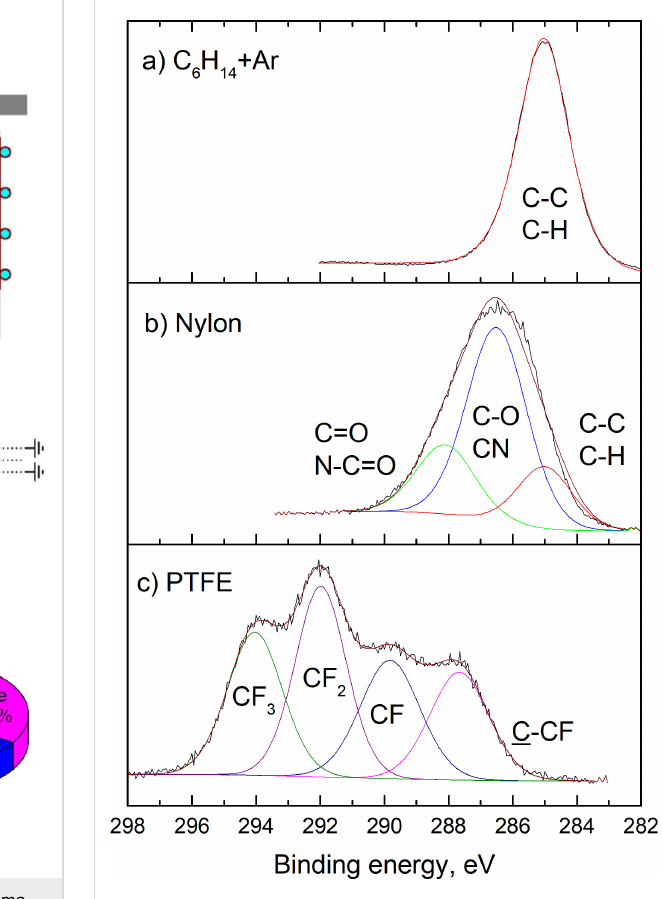
Figure 4: C 1s XPS of the NPs prepared a) by plasma polymerization of n -hexane in its mixture with Ar (total pressure 88 Pa, discharge power 40 W, C 6 H 14 flow 1.2 sccm, Ar flow 12.2 sccm); b) by RF mag- netron sputtering of nylon in the Ar/N 2 3:1 mixture (obtained in a